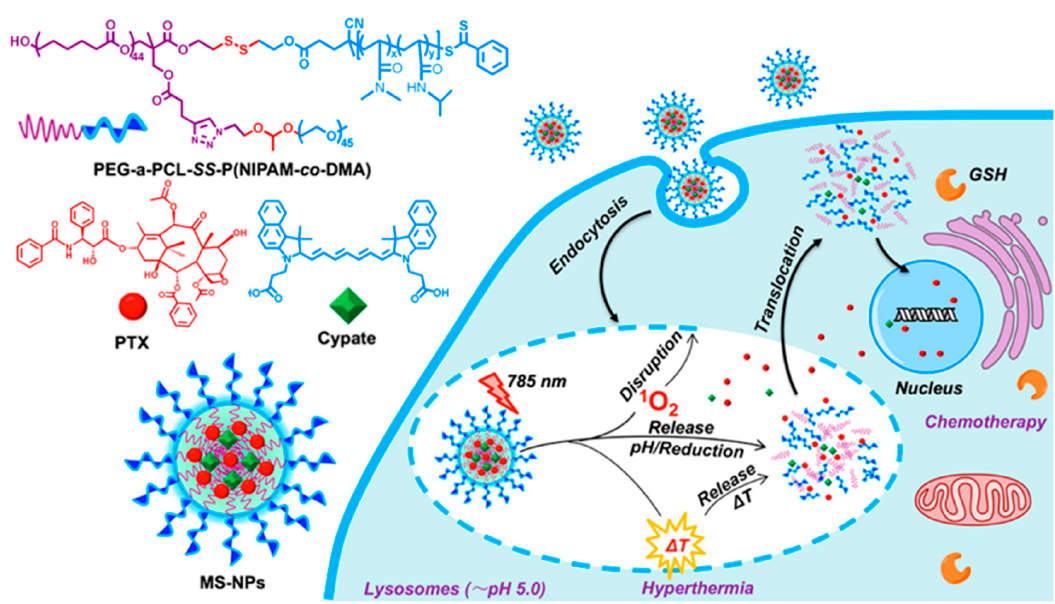
Figure 8. Schematic illustration of NIR light/pH/reduction–responsive nanoparticles consisting of PEG- a -PCL-SS-P(NIPAM- co -DMA) star quaterpolymer for precise cancer therapy with synergistic effects. PEG: poly(ethylene glycol); PCL: poly( ε -caprolactone); SS: disulfide; P(NIPAM): poly(N-isopropylacrylamide; DMA: N , N -dimethylacrylamide. GSH: glutathione; MS-NPs: multi-stimuli-responsive nanoparticles; PTX: paclitaxel. Reproduced with permission from An, X.; Zhu, A.; Luo, H.; Ke, H.; Chen, H.; Zhao, Y. Rational design of multi-stimuli-responsive nanoparticles for precise cancer therapy. ACS Nano 2016 [168].